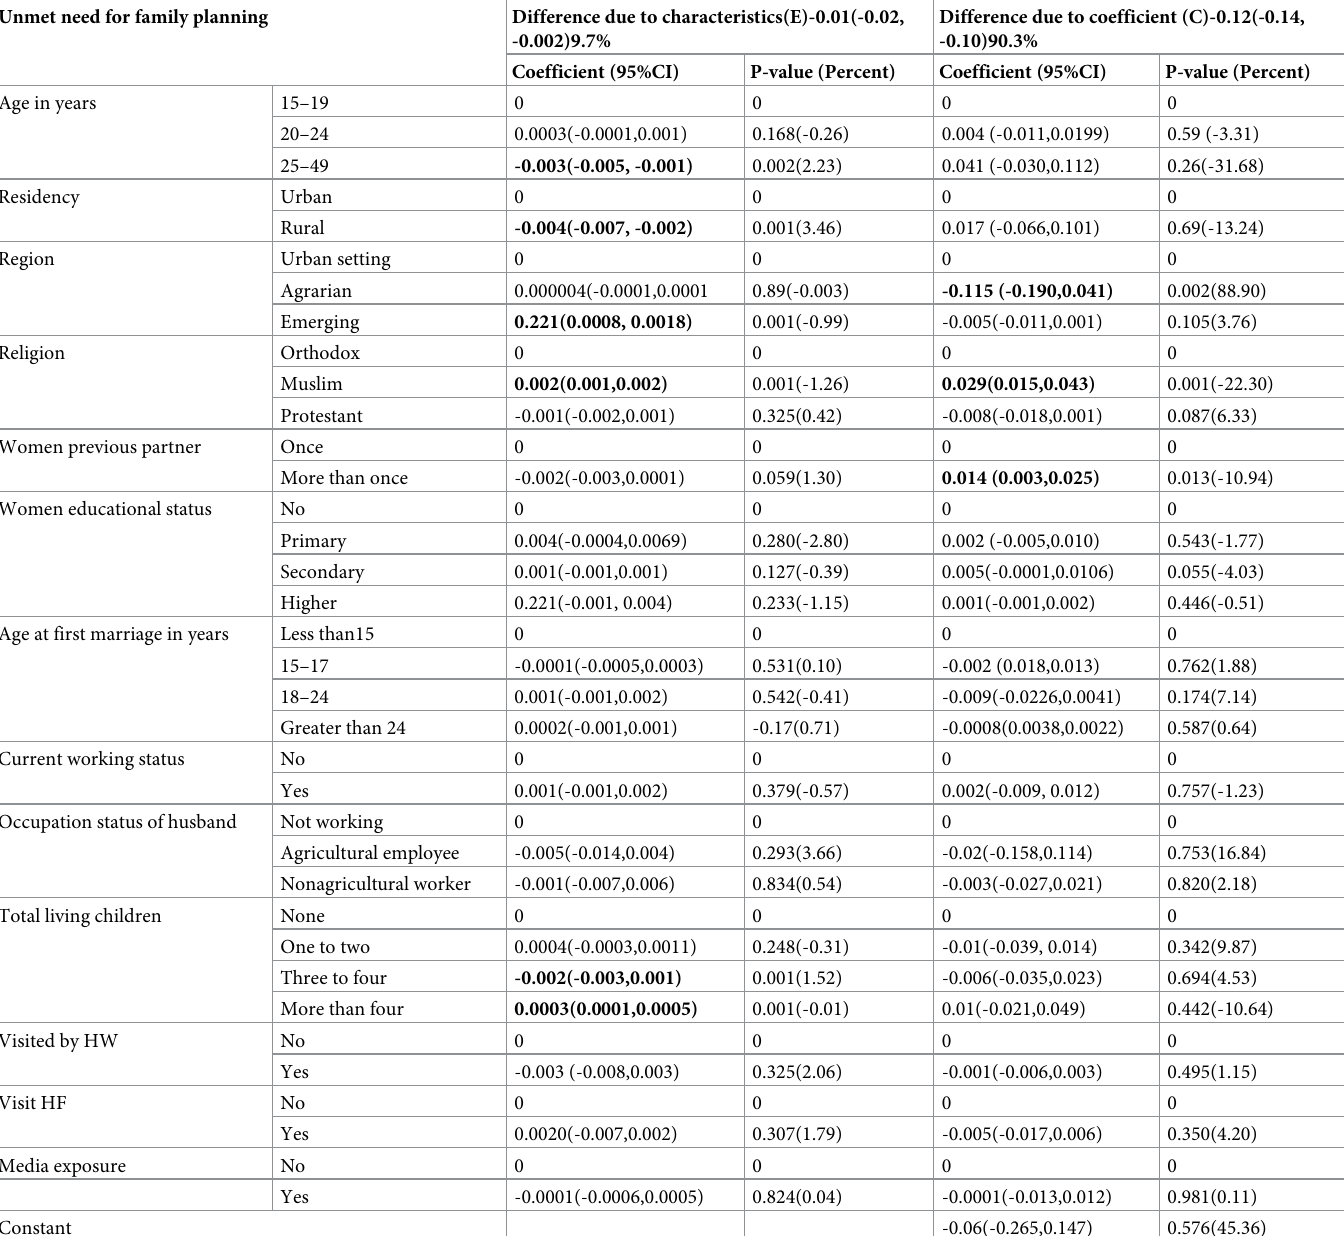
Table 4. Detailed decomposition analysis of change in unmet need for family planning among currently married women in Ethiopia 2005–2016. Unmet need for family